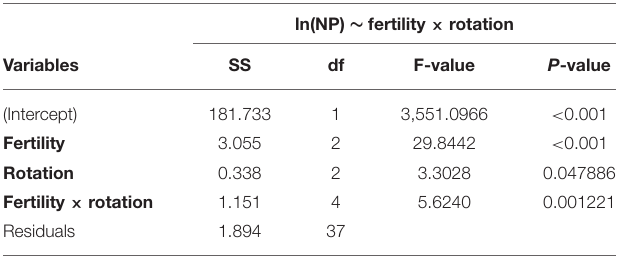
TABLE 1 | Two-way analysis of variance (ANOVA) table for model assessing the influence of long-term fertility (MLP, IN, UF) and rotation (CC, CS, COA) on natural log transformed nitrification potential (NP) activity in the Morrow